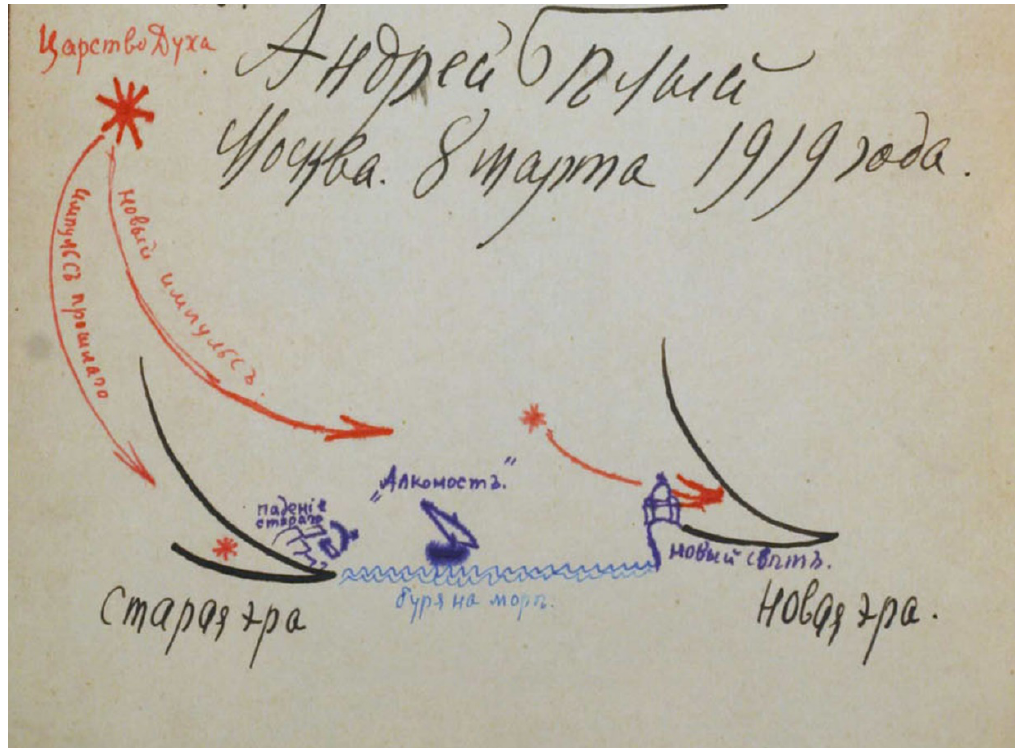
Figure 2. Andrei Bely. Drawing from Samuil Alyanski’s album. 1919. The State Museum-Reserve of D.I. Mendeleev and A.A. Blok.